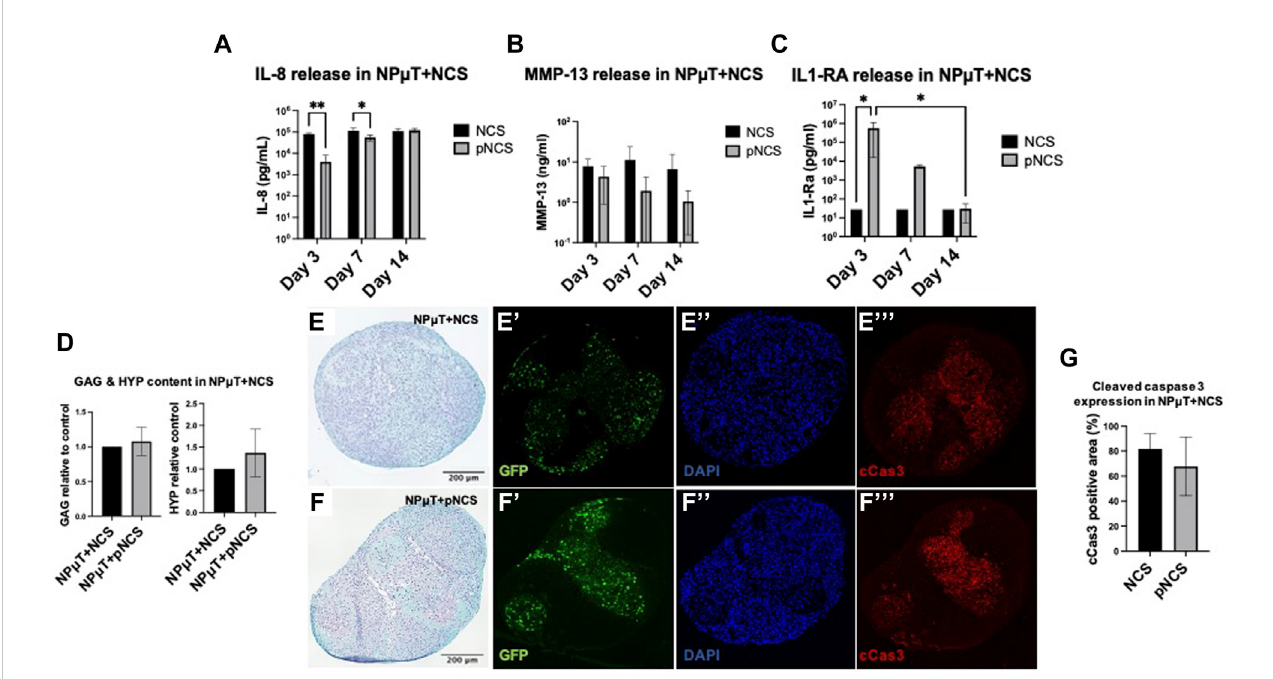
FIGURE 6 Implementationofpre-conditionedNCS(pNCS)inNPµTmodel. (A) IL-1Ra, (B) MMP-13, (C) IL-1RareleasefromNPµT+NCS/pNCSwasassessedonday 3,7,and14(NP: n =1,NC: n =3,mean±SD,* p < 0.05,ANOVA). (D) Glycosaminoglycan(GAG)andhydroxyproline(HYP)quanti fi cation,normalisedtoNPµT+ NCS (NP: n = 1, NC: n = 3, mean ± SD, * p < 0.05, ANOVA). SafO/FG staining of NPµT containing (E) NCS and (F) pNCS, visualising